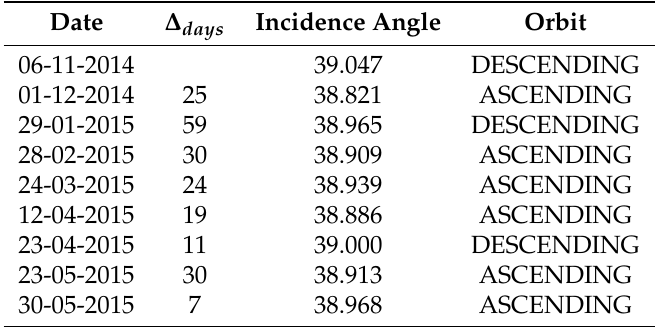
Table 3. Sentinel-1 imagery used for this study.